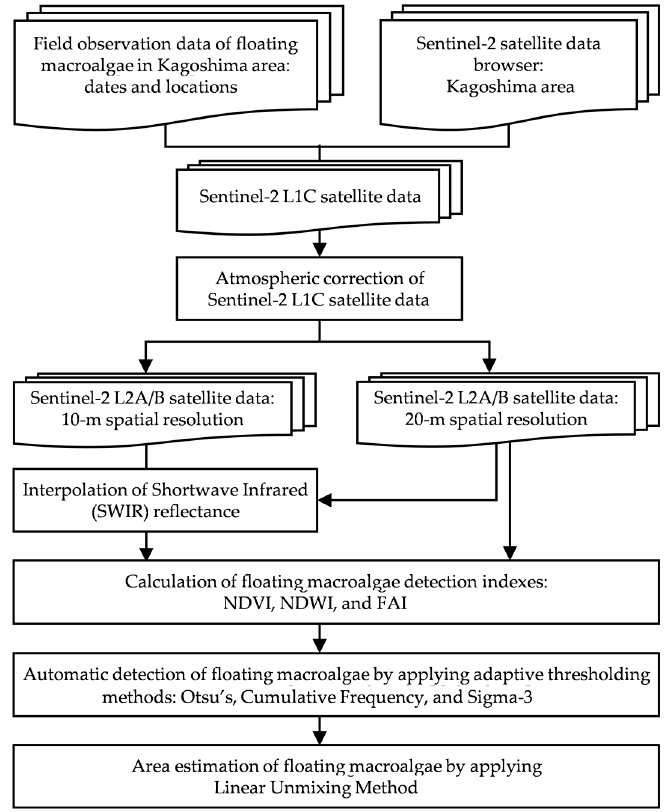
Figure 1. Study procedure. Initially, viable Sentinel-2 satellite data were acquired through atmospheric